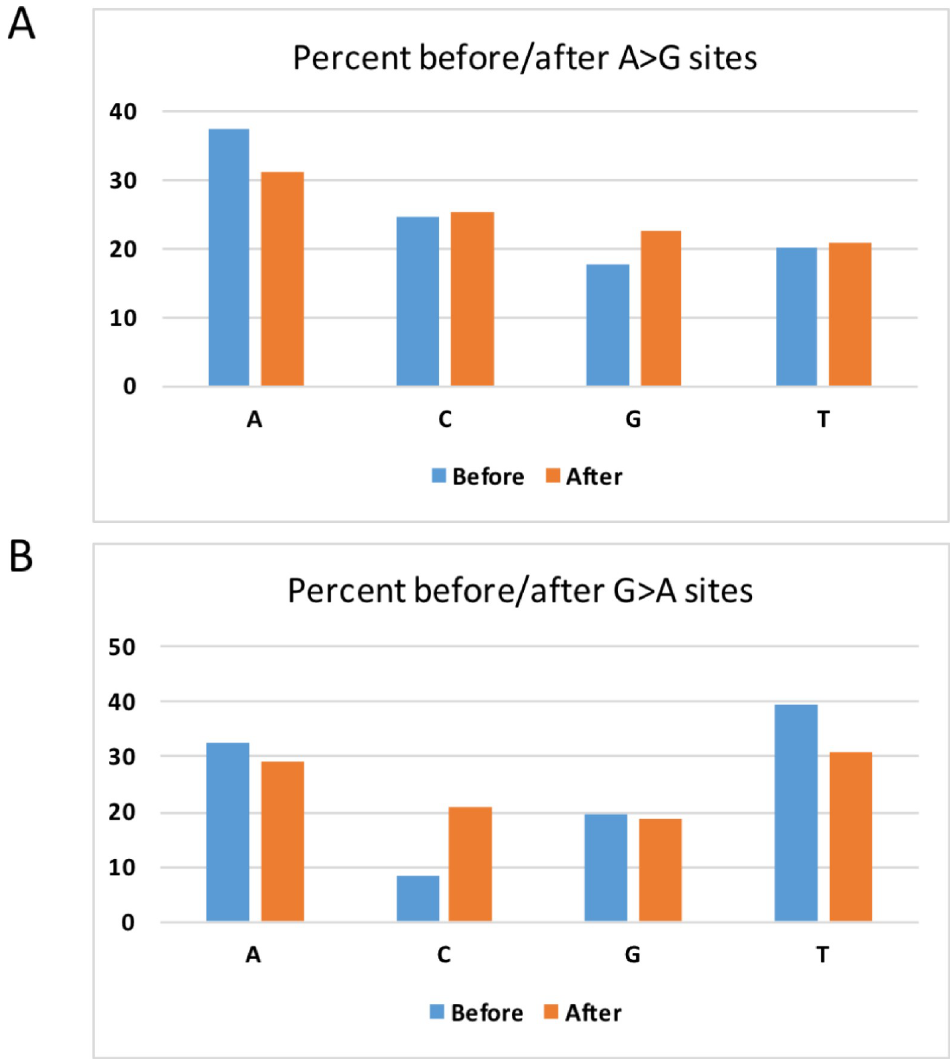
Fig 5. The base context of unique mutation sites. The percentage of A, C, G, and T is provided as bars. (A) Context of A-to-G sites. (B) Context G-to-A sites. "Before" means the five-prime nucleotide. "After" means the three-prime